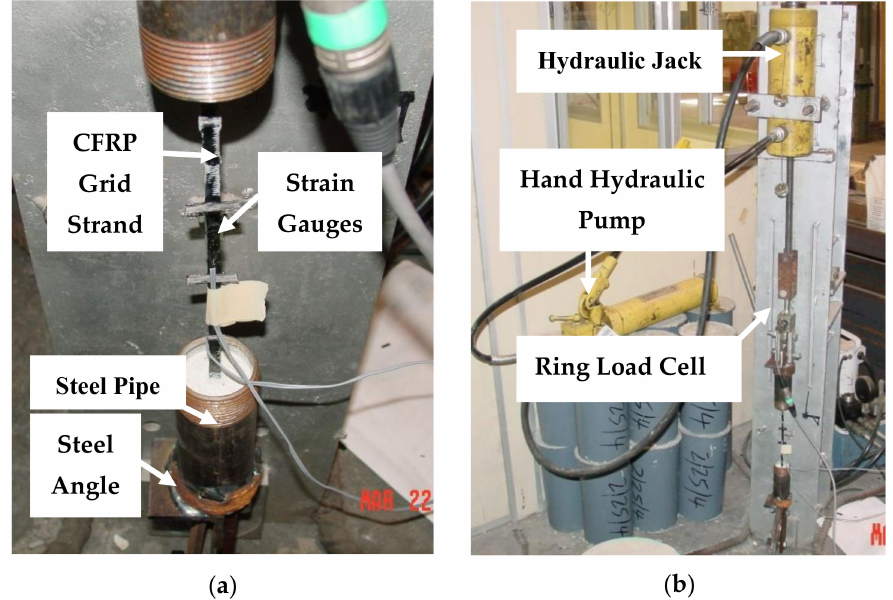
Figure 2. ( a ) CFRP grid stand specimen anchored using an expansive grout inside a steel pipe attached to the loading set-up using steel angles, and ( b ) test set-up for tensile testing, with a CFRP grid strand specimen attached to the loading frame using a hydraulic jack to apply force and a ring load cell to measure the total force applied [3].